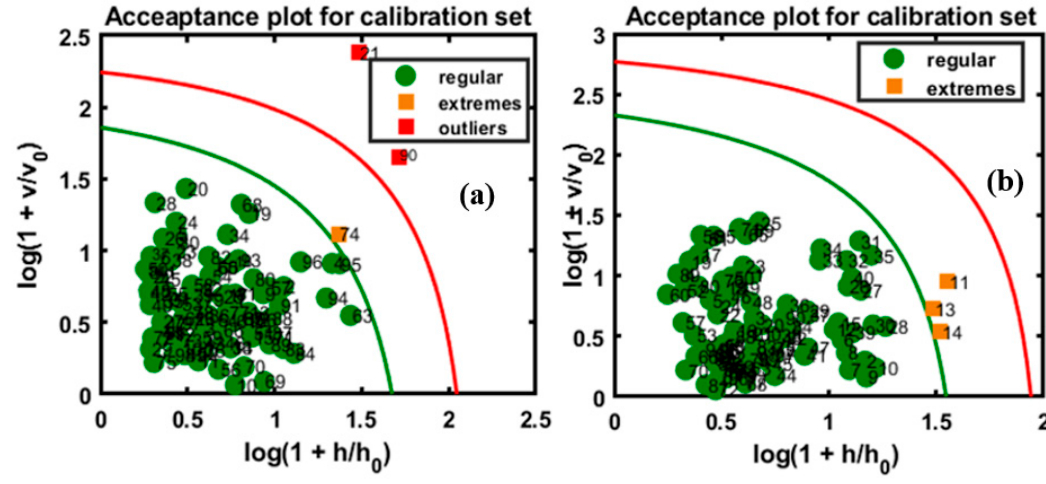
Figure 7. Calibration model based on FT-IR ( a ) and FT-NIR ( b ) data.